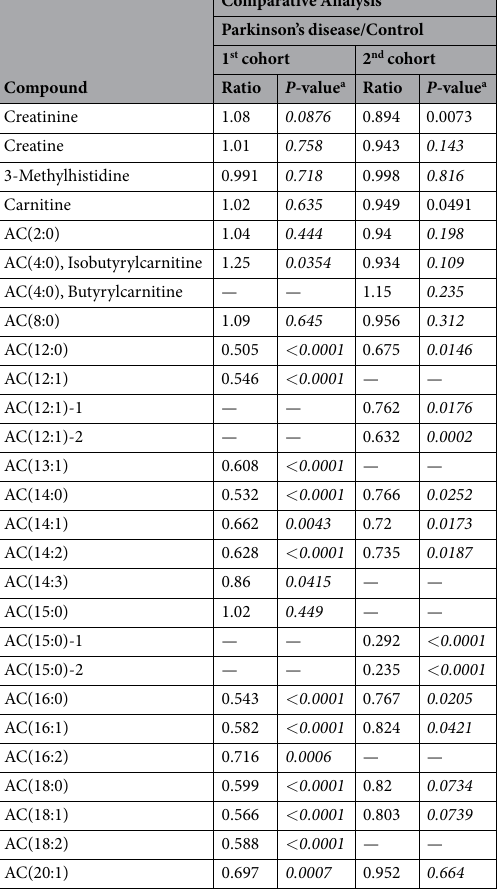
Table 3. List of carnitine and acylcarnitines detected in both cohorts. Abbreviations: AC = acylcarnitine. a P - value obtained by Wilcoxon’s test, comparing between PD and